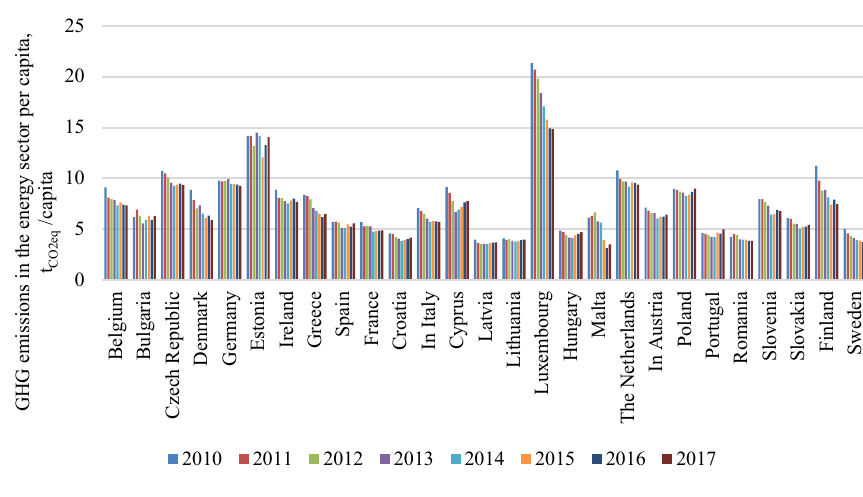
Fig. 2. GHG emissions per capita in EU countries, 2010–2017.